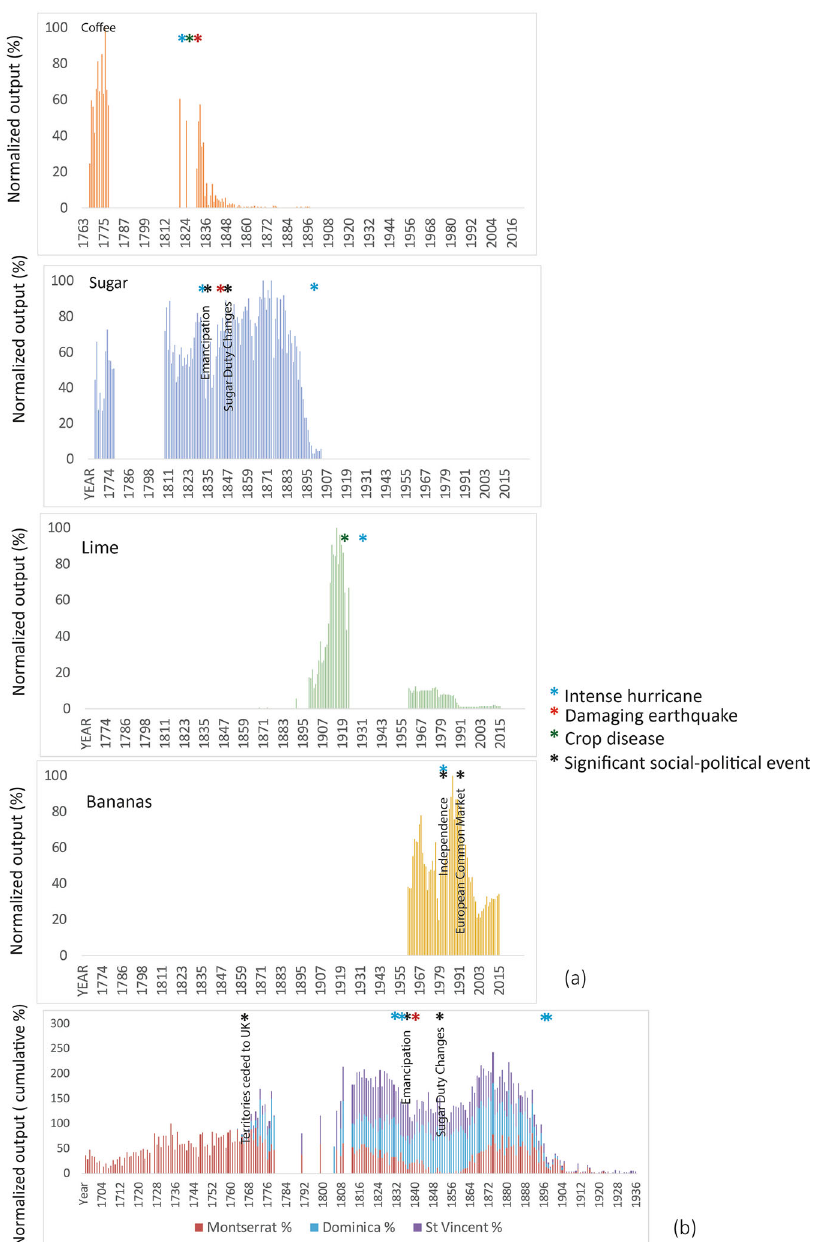
Fig. 2 a The boom and bust of coffee, sugar, lime, and banana production in Dominica, 1763–2016. b Disaster impacts on sugar export crops in three Eastern Caribbean volcanic islands, 1700–1937. In a values are normalized against the year of peak productivity for each crop. Conversions have been used for lime outputs as follows: lime was exported in three main products at varying times—raw and concentrated lime juice, citric acid, and lime essence. Until 1892 reporting discovered focused on the lime juice. From 1900 lime was reported as its total export value across the three products. In the FAO reporting (FAOSTAT 2019) it is declared as tons. Thus a conversion was applied using the reported volume of juice and value equivalency reported in Hamilton (1894). A conversion in this volume of around 1 gallon of concentrated juice per barrel of limes was used to determine the no. of barrels that this was equivalent to in 1892 (33,148). In 1892 both the value and the amount (liquid mass) were reported. Using a